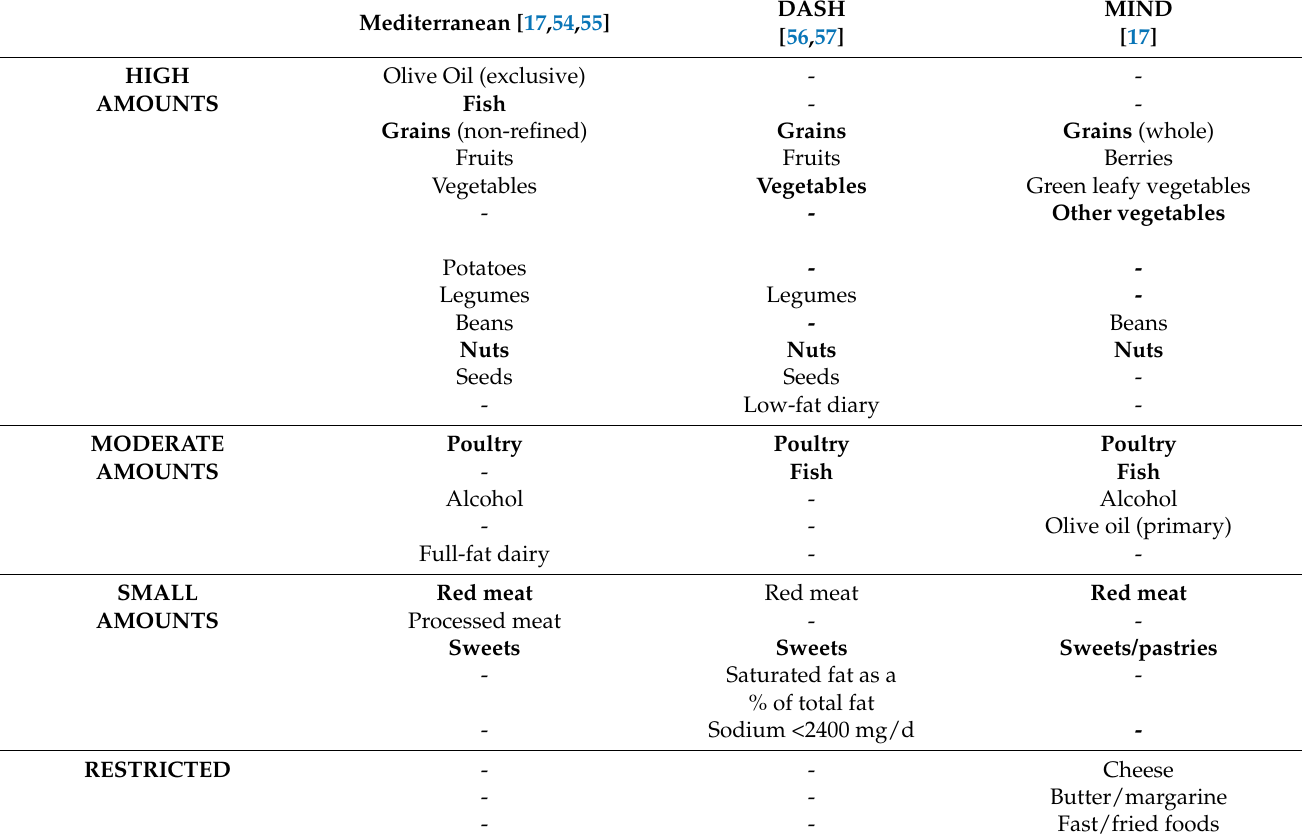
Table 2. Comparison of Mediterranean, DASH, and MIND dietary components. The components in bold are common across all three dietary